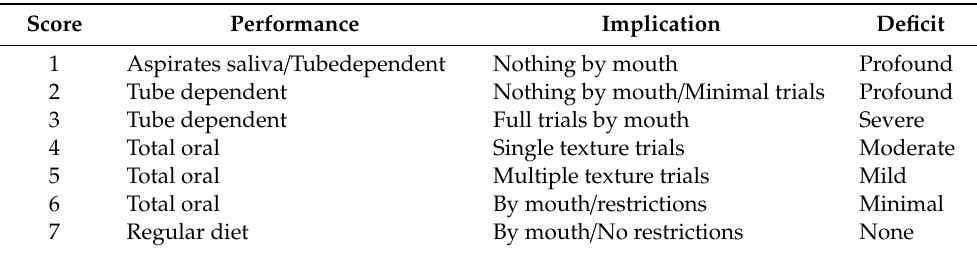
Table 1. The Functional Oral Intake Scale